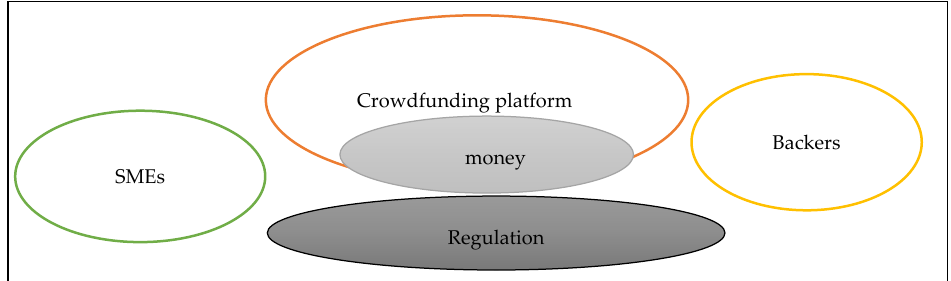
Figure 1. Crowdfunding Model. Source: Adapted from Shneor (2020).